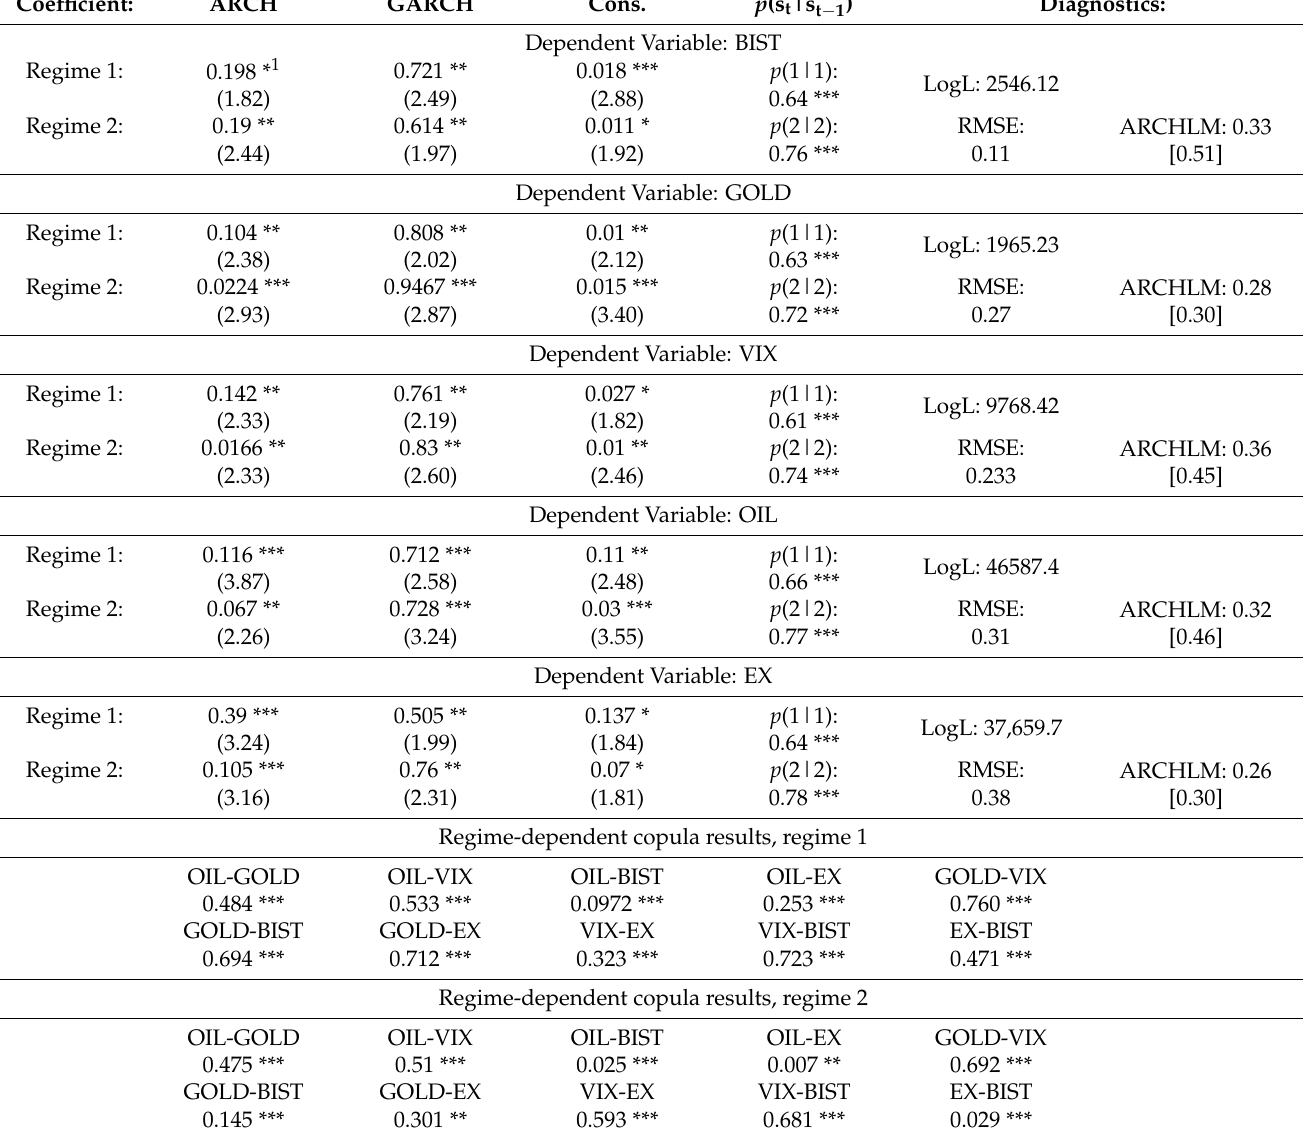
Table 5. MS-GARCH copula model results for return